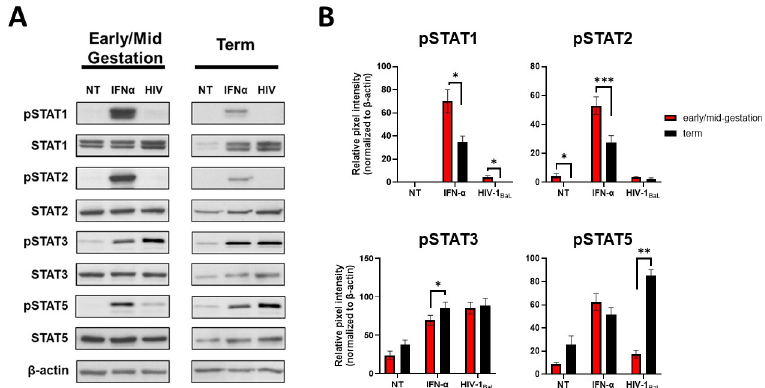
Fig 8. Differential Levels of STAT Protein Activation in Term HCs may contribute to observed Increases in HIV Replication. A , Hofbauer cells were infected with HIV-1 BaL , treated with IFN- α (100 IU/mL), or left untreated (NT) for 72 hours. Lysates were prepared and subjected to sodium dodecyl sulfate–polyacrylamide gel electrophoresis. The gel was blotted and the indicated proteins were detected by immunoblotting with indicated antibodies. B , The pixel